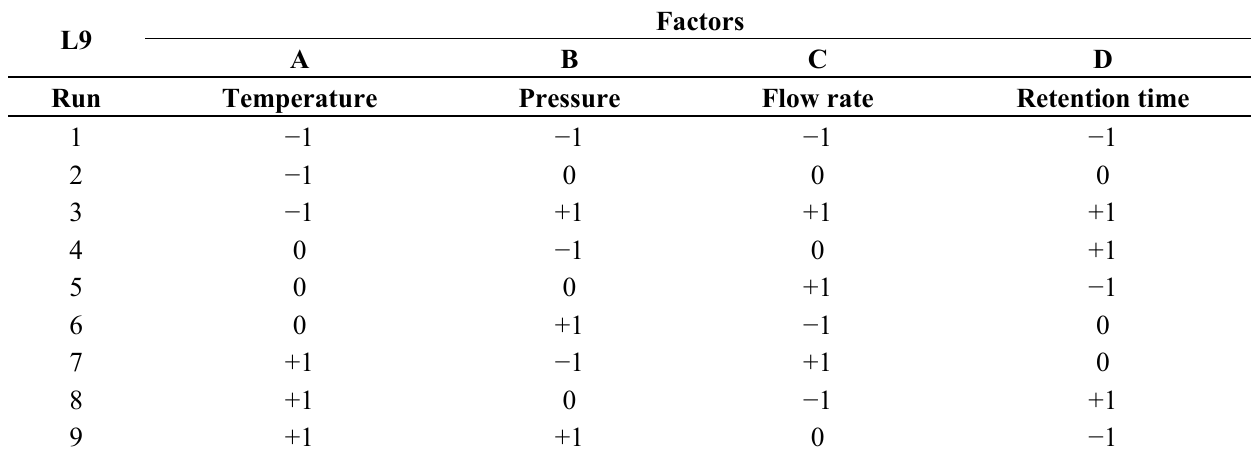
Table 1. Experimental plan by the L9 Taguchi design applied to biodiesel production.